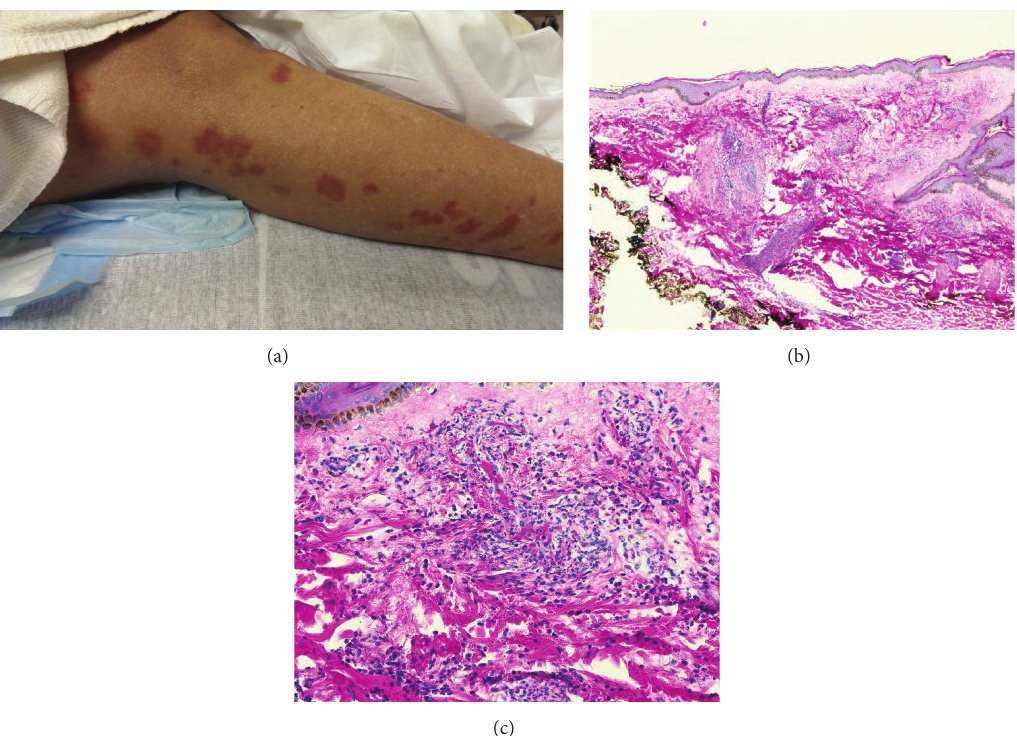
Figure 1: Drug-induced small vessel vasculitis. (a) Skin rash in lower extremities. (b) H&E staining from skin punch biopsy (20x) showing dense infiltrate of neutrophils and eosinophils surrounding vessels with extravasation of red blood cells. (c) H&E staining from the same skin punch biopsy